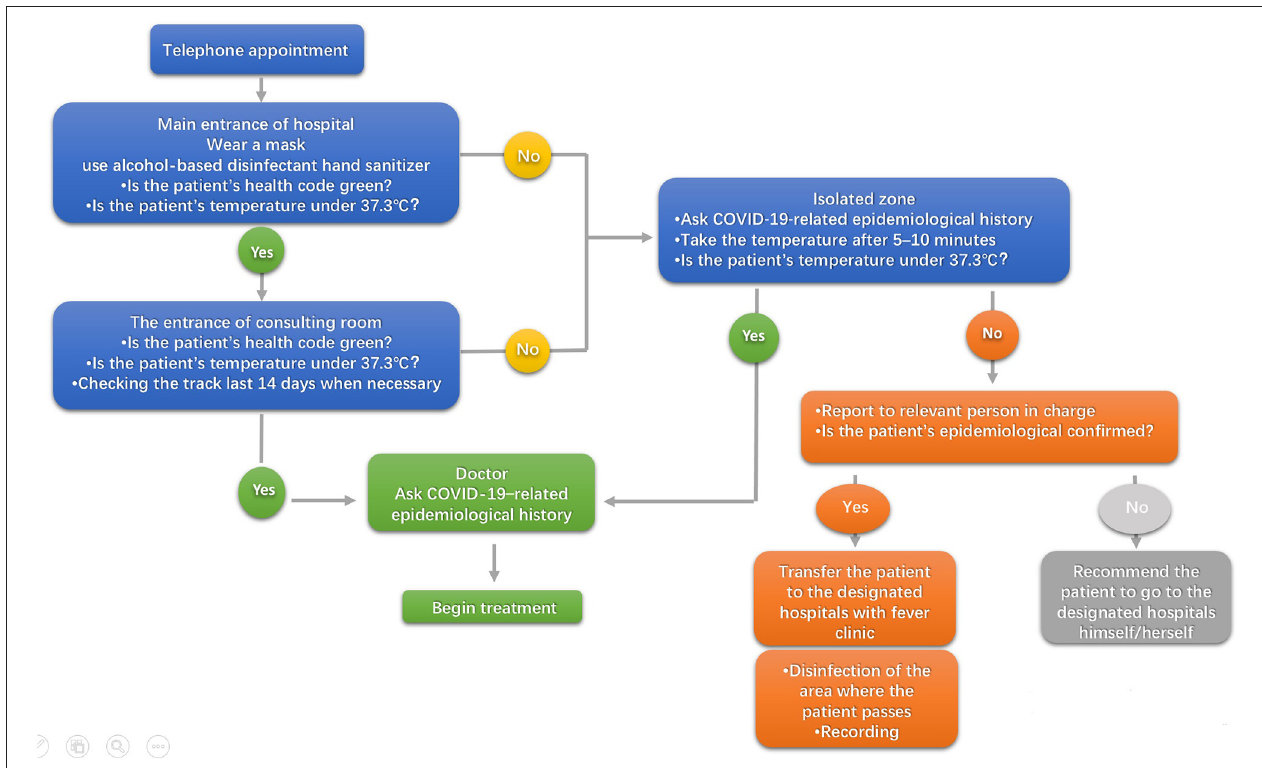
FIGURE 2 | The procedure for prognostics and